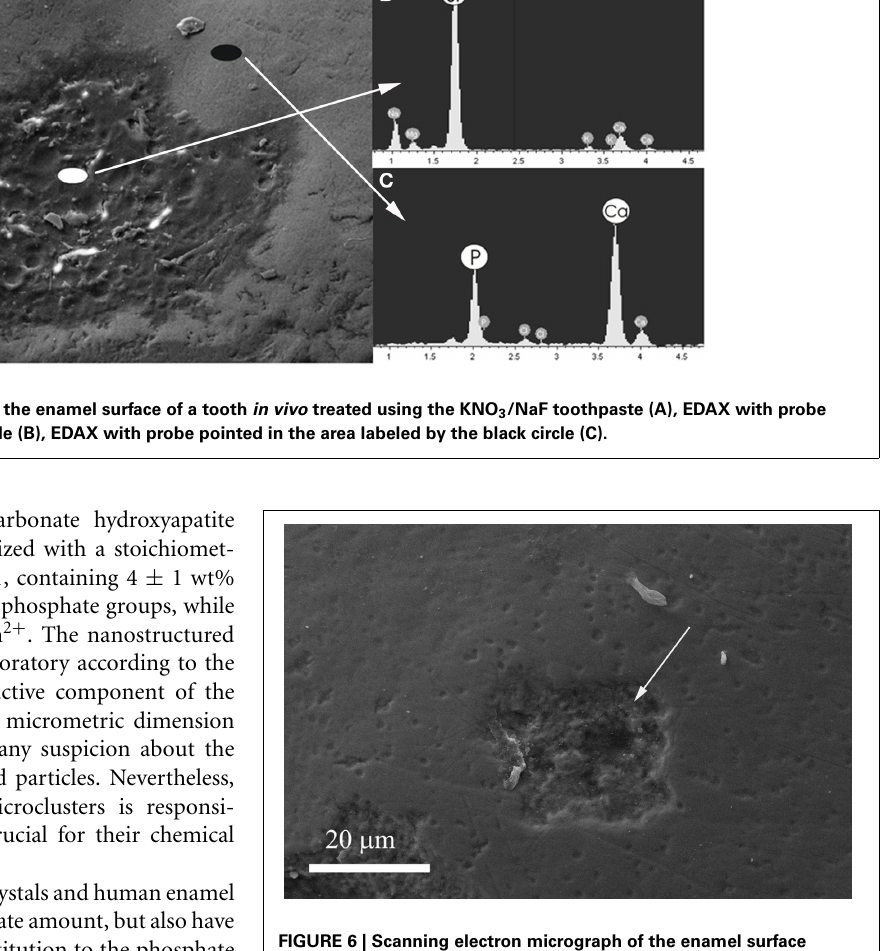
FIGURE 6 | Scanning electron micrograph of the enamel surface treated using a non-specified fluoride toothpaste, showing a zone of enamel loss